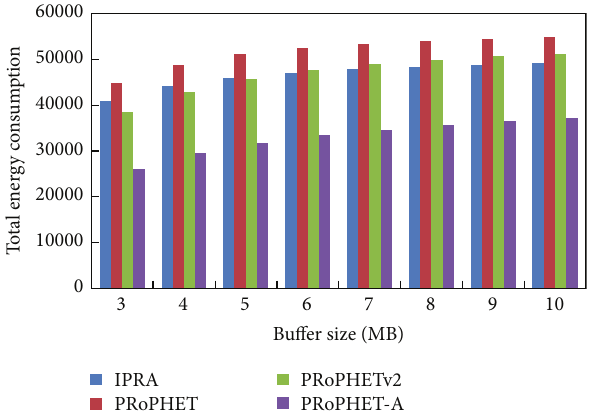
Figure 15: Average delay (AD) under different scenarios.